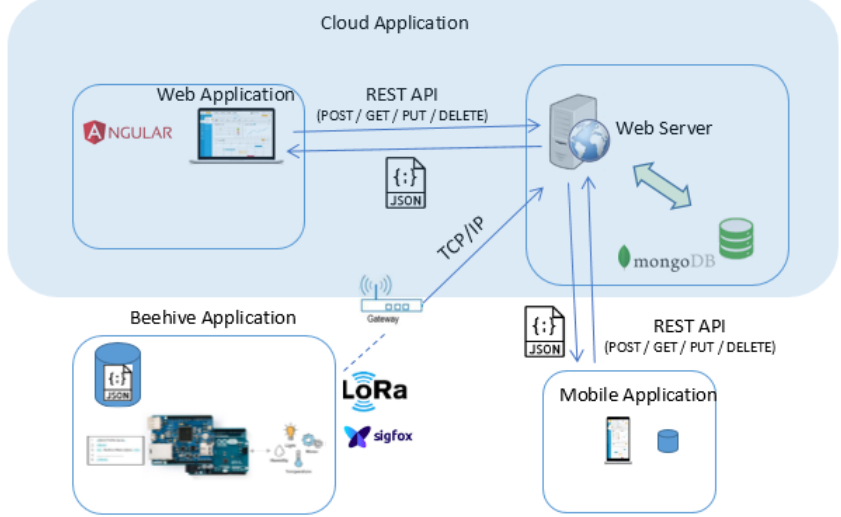
Figure 9. An example of the proposed